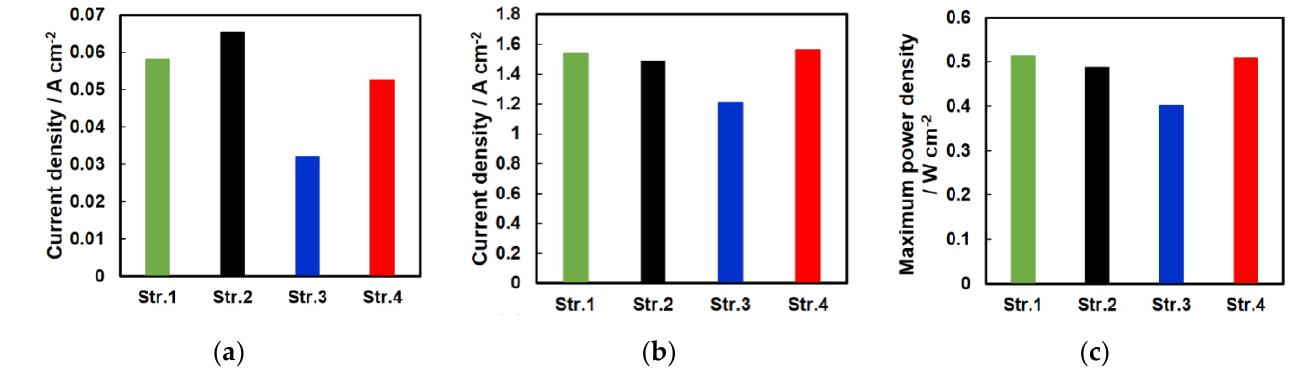
Figure 7. Performance of the four CCLs at ( a ) 0.6 V and ( b ) 0.2 V and the ( c ) maximum power density at 100% RH.